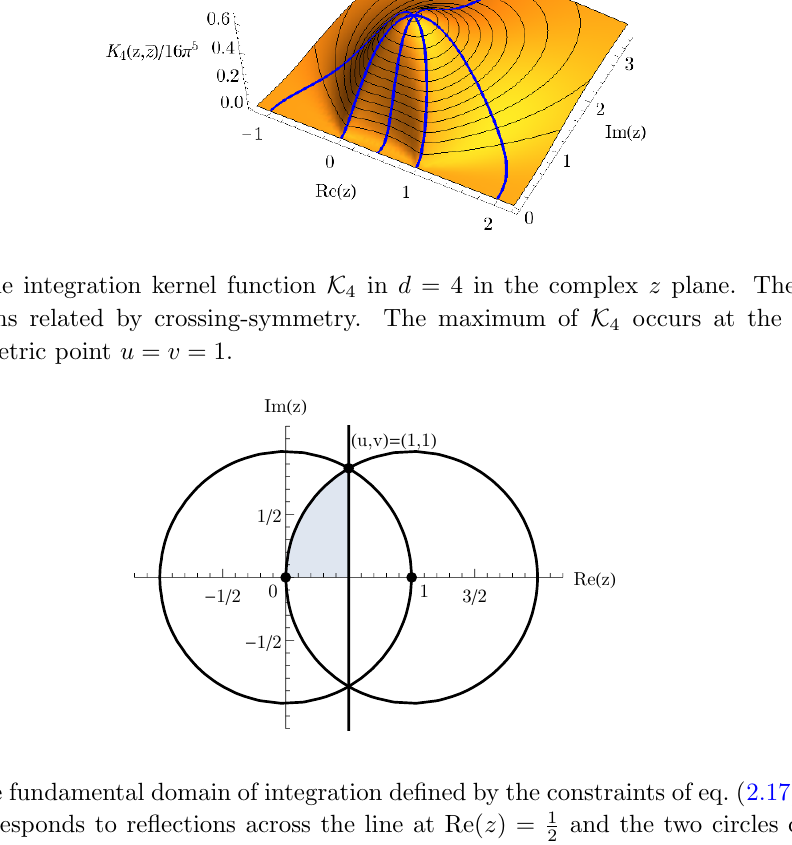
and the two circles centered at 2